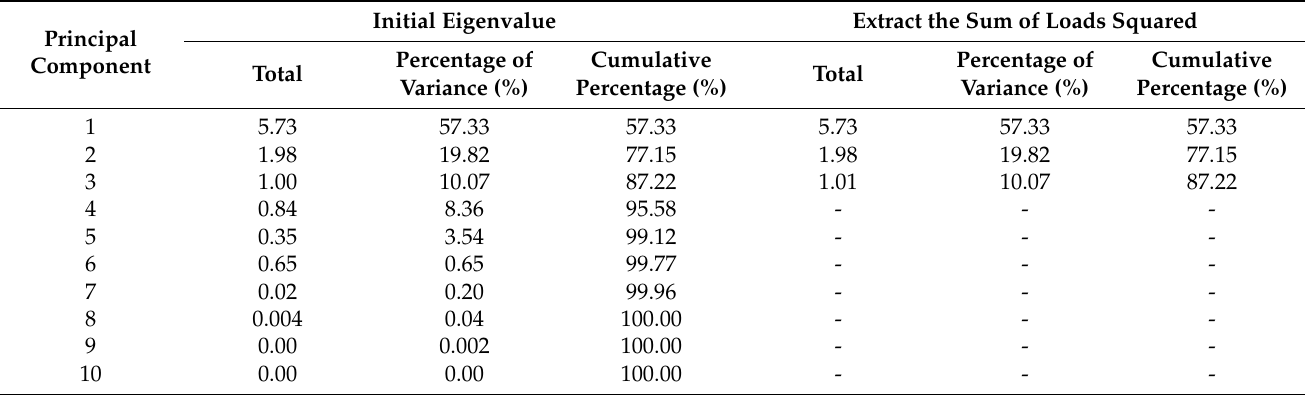
Table 2. Parameters of the 10 principal components obtained from the principal component analysis.